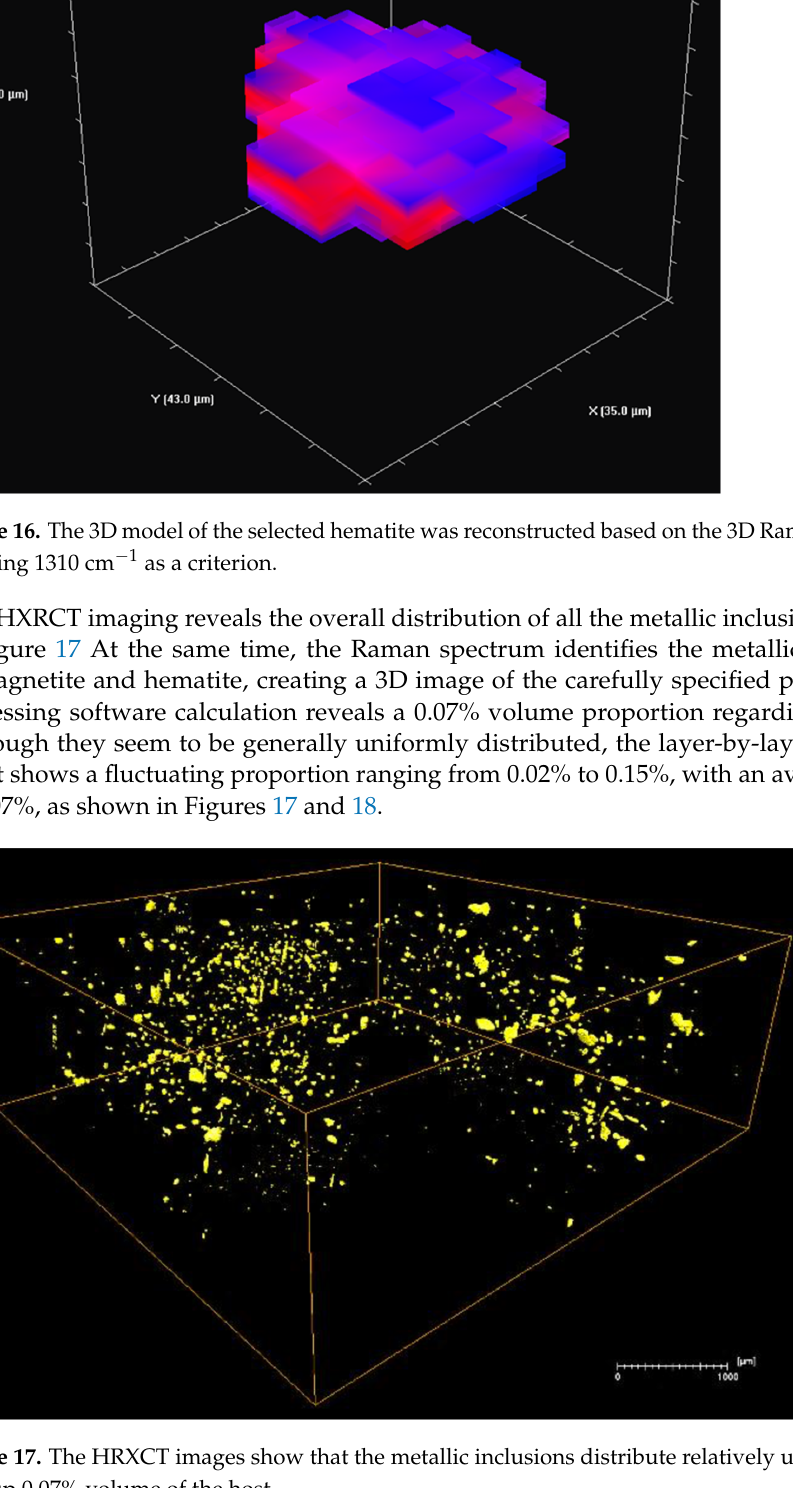
Figure 18. Diagram of volume proportion change in the metal minerals along the direction of sample thickness. 3.2. The Voids Among the host, numerous tiny voids were observed, filled with multiple phases, as shown in Figure 19. Most of the voids showed a flattened shape parallel to the (0001) basal face with an irregular or elongated outline (Figure 20). Raman tests identify the phases as a mixture of CO 2 and N 2 , with two prominent peaks at 1280 and 1386 cm − 1 assigned to CO 2 and one strong peak at 2328 cm − 1 attributed to N 2 (Figure 21). The movability of these fluids prohibits further 3D Raman mapping.